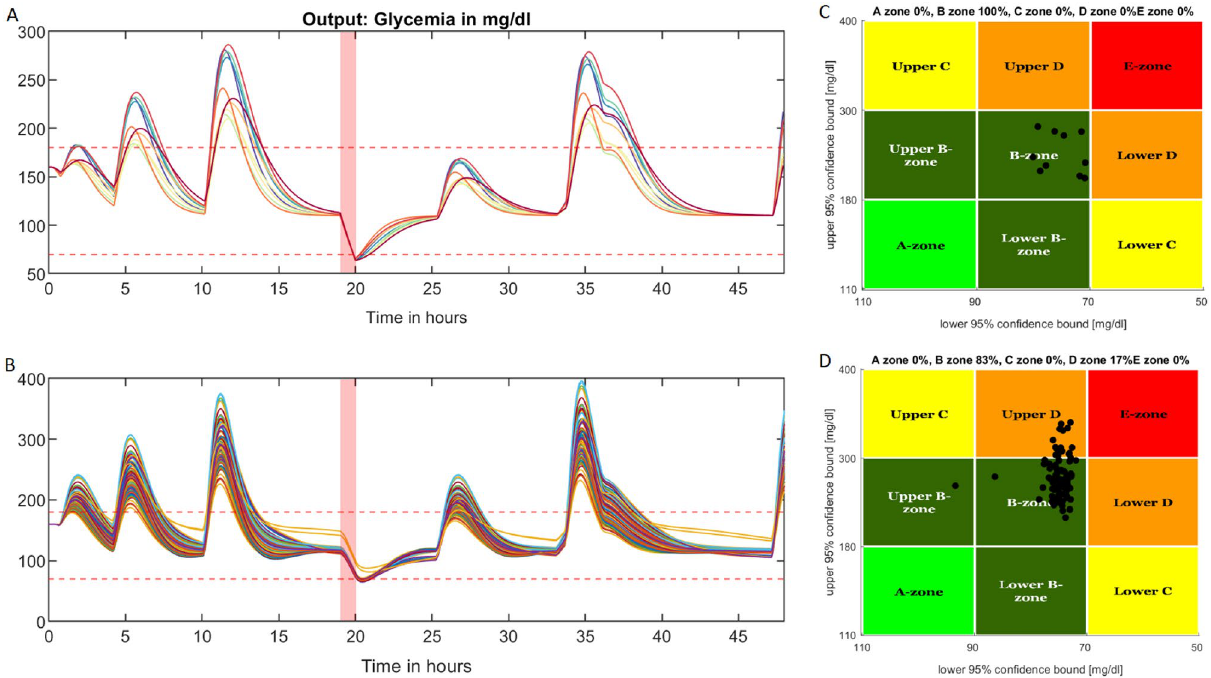
Figure 4. Control law performance comparison on a cohort of virtual patients and a simulator from the literature. ( A ) Simulation scenario and the results of our 10 virtual patients obtained by using our state-feedback controller. The horizontal dashed-lines represent the hypoglycaemia and hyperglycaemia thresholds (resp. 70 mg/dl and 180 mg/dl), respectively. The red-coloured area corresponds to the physical activity period. The 48-h scenario presented here included 3 meals on the first day, followed by an exercise bout and 3 more meals the next day. ( B ) Simulation of the 99-patient cohort from the OHSU simulator using our control algorithm and the same scenario as above. The horizontal dashed-lines have the same meanings as those in panel ( A ). ( C ) Control- variability grid analysis for our patient cohort with each black dot representing a patient according to their time spent in and out of the glycaemic range with a 95% confidence interval. All patients remained in the B-zone meaning that the control law kept glycaemia within the target range. ( D ) Control-variability grid analysis for the OHSU